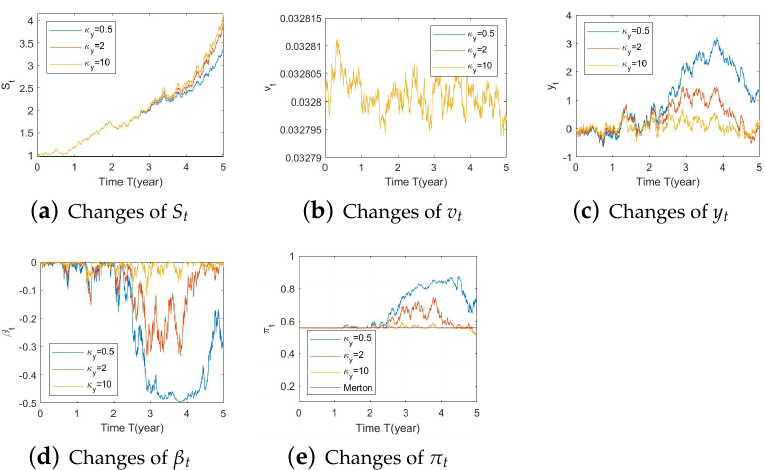
Figure A1. Illustrate the impact on ( a ) stock prices, ( b ) driver of volatility, ( c ) driver of elasticity, ( d ) elasticity of volatility, and ( e ) optimal stock allocations when varying the speed of reversion, κ y ( e . g ., κ y = 0.5,2,10 ) .